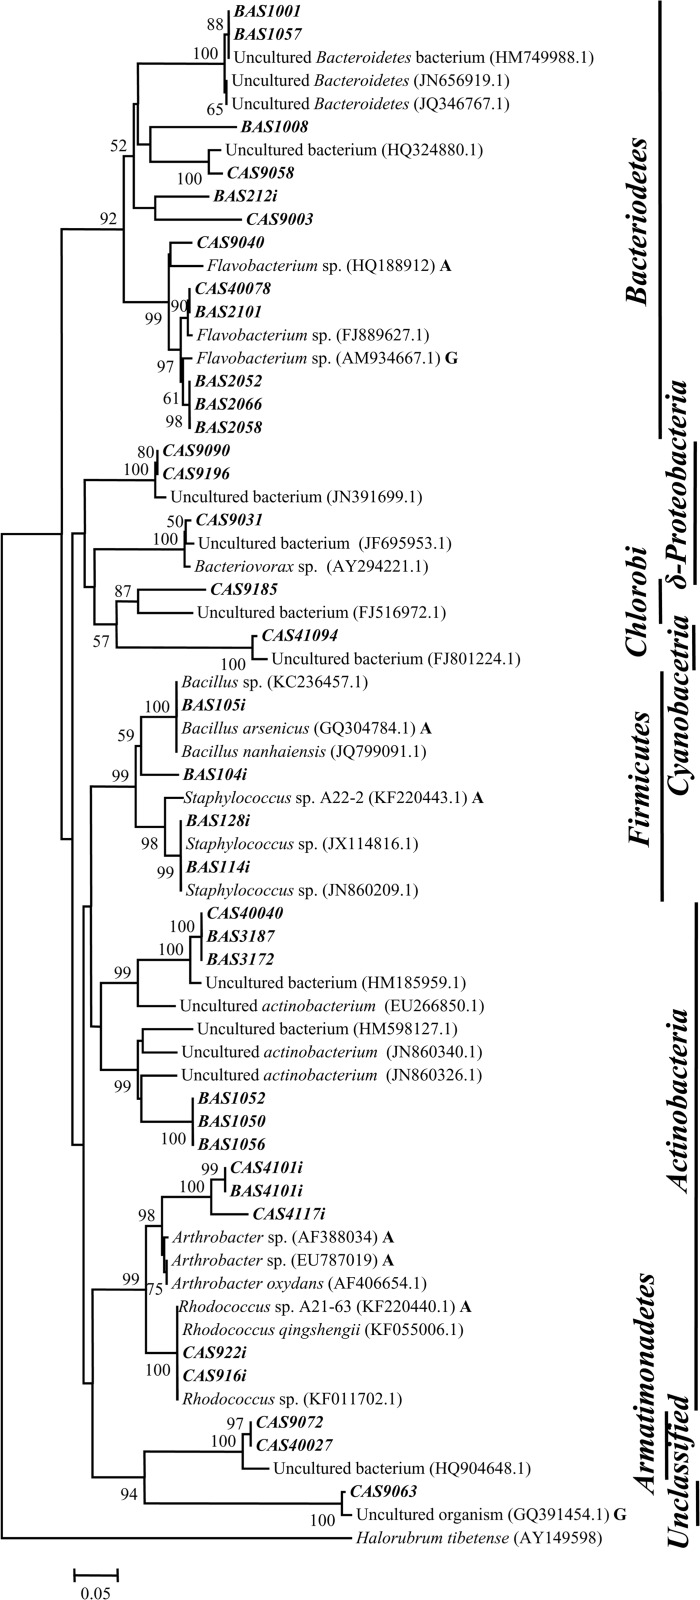
Neighbor-joining phylogenetic tree of δ-Proteobacteria, Actinobacteria, Cyanobacteria and other groups.The tree is based on 16S rRNA gene sequences using by Jukes-Cantor distances. 1000 bootstraps analyses are conducted and more than 50% are denoted in nodes. Sequences retrieved from As contaminated environment and groundwater are suffixed here as ‘A’, and ‘G’, respectively. Sequences represented in bold italic font are derived from clone libraries and bold italic font with a suffix ‘i’ are derived from isolated strains.